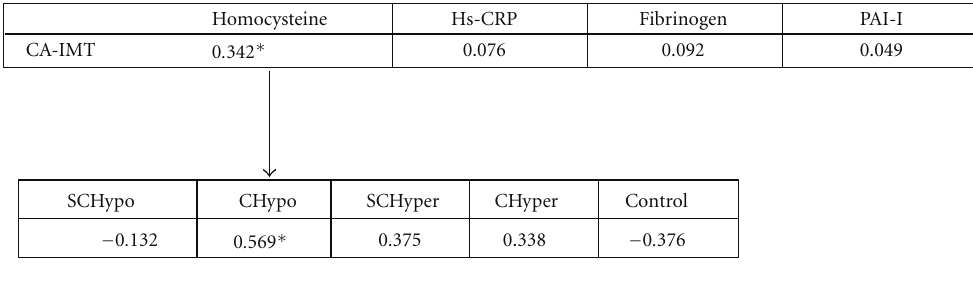
Health survey, no di ff erence in patients with subclinical hypothyroidism ( n = 112) compared to patients with TSH ≤ 4.6 mcu/mL (643) was observed [40]. Our study confirms the finding that levels are higher in